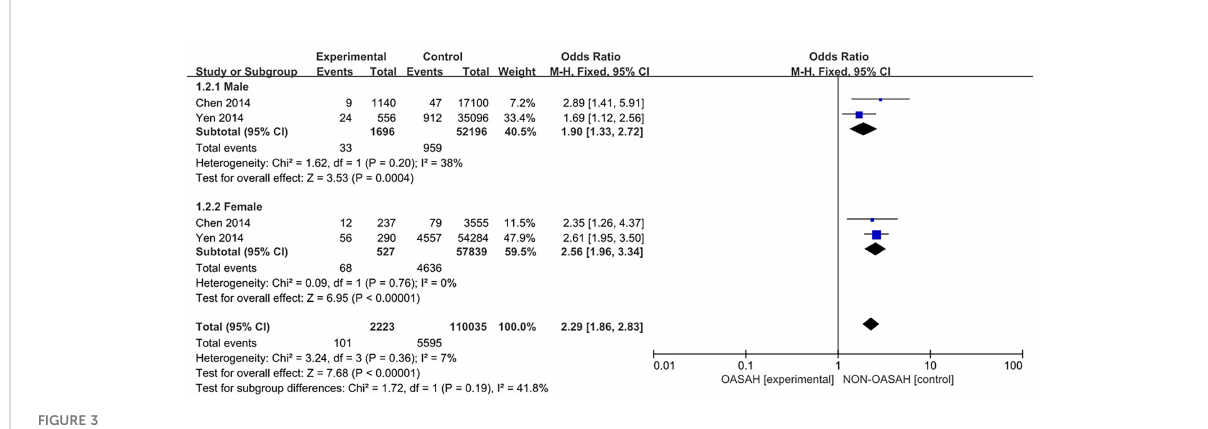
FIGURE 3 Forest plot of incidence of osteoporosis in male and female subgroups.